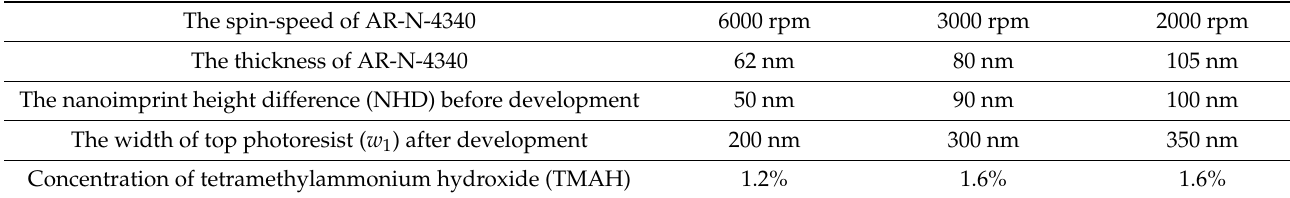
Table 1. The effect of the spin-speed of top